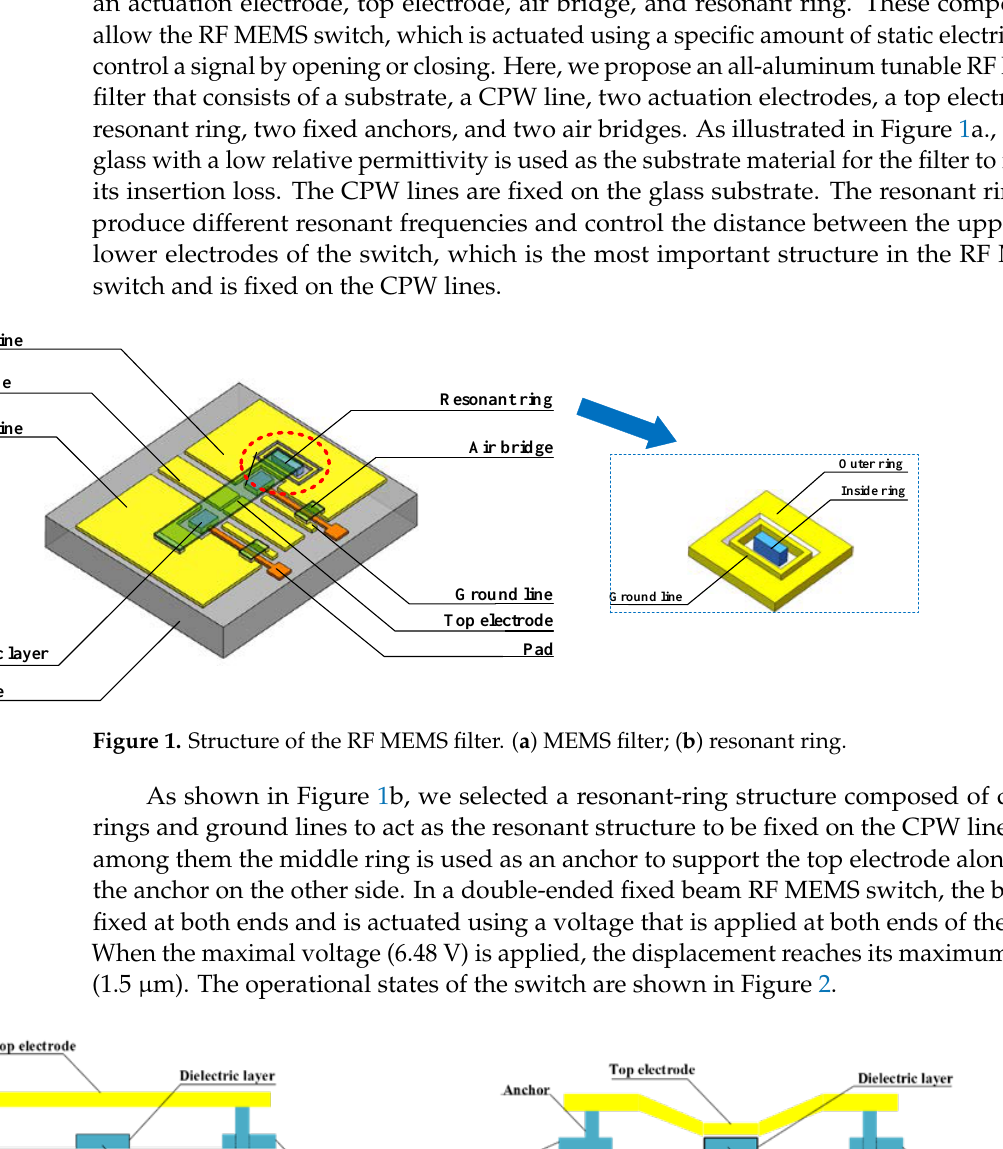
Figure 2. Cross-sectional views of filter operation:( a ) off state; ( b ) on state.